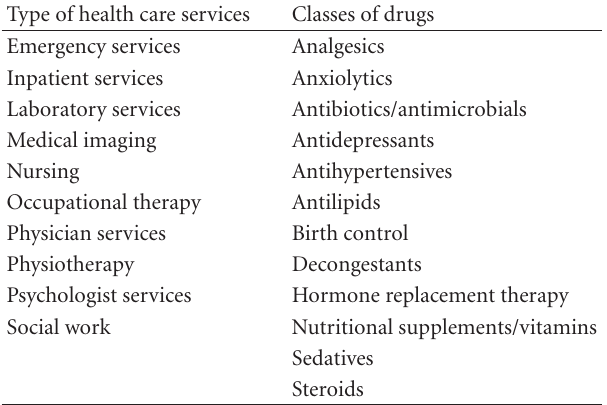
Table 1: Health care services and classes of drugs used by study